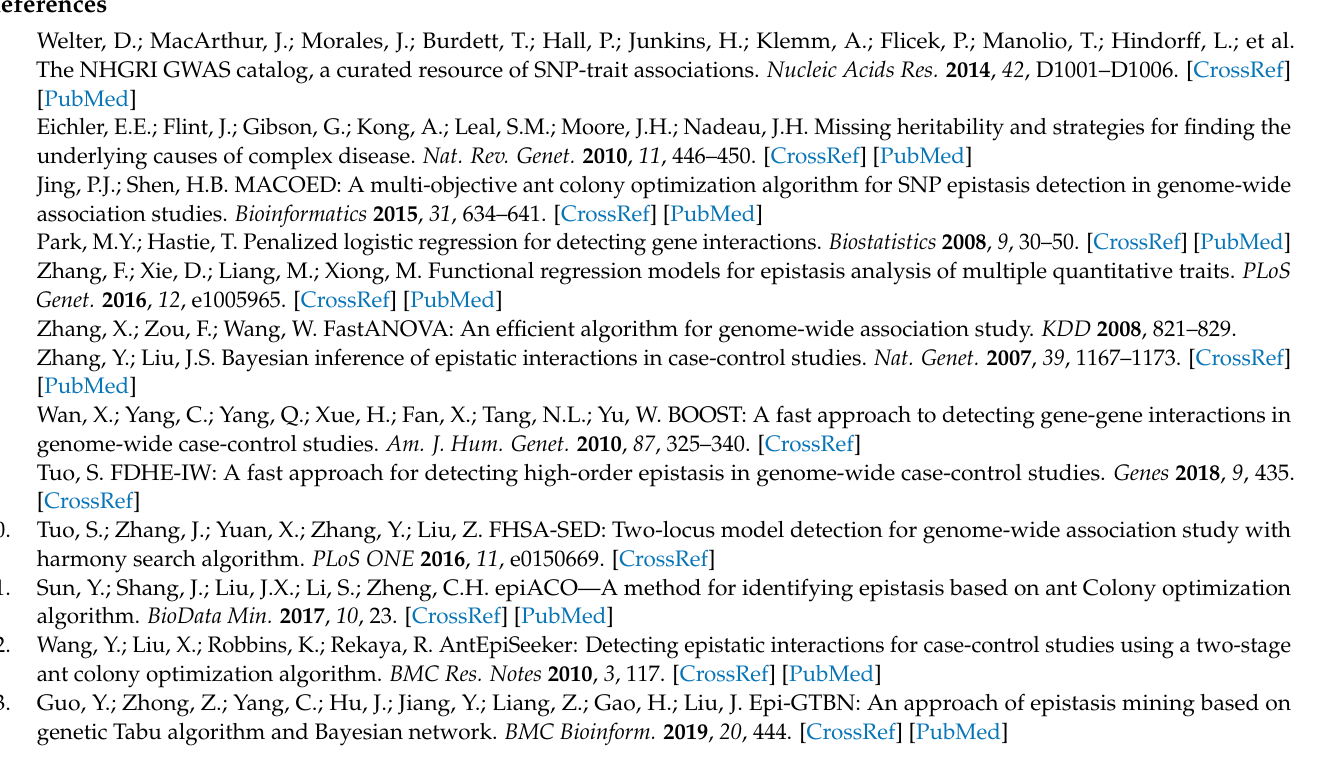
efficiency and accuracy comparisons between EpiMOGA and the single-objective method, Figure S3: A line diagram of the standardized values of the Power and time, Figure S4: Detection efficiency comparisons between EpiMOGA and other comparative methods on DME models with 5 different SNP number, Figure S5: The detect time of EpiMOGA and Epi_GTBN on different datasets, Figure S6: SNP-SNP network of 3-order epistasis detection, Table S1: Penetrance functions of the three DME epistasis models, Table S2: Penetrance tables of the DME and DNME epistasis models with different sets of parameters, Table S3: Top-10 3-order epistasis interactions associated with AD. All the simulate data and code can be found here: